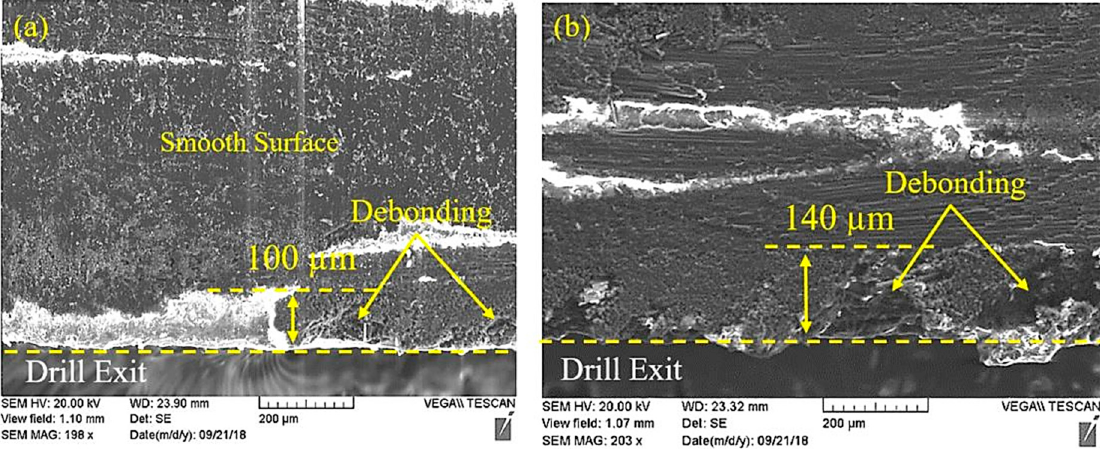
Figure 14. The scanning electron microscopic (SEM) examination of LF-VAD machined hole at f = 0.075 mm/rev and N = 3000 rpm on the exit surface for ( a ) A m = 0.07 mm and ( b ) A m = 0.48 mm.